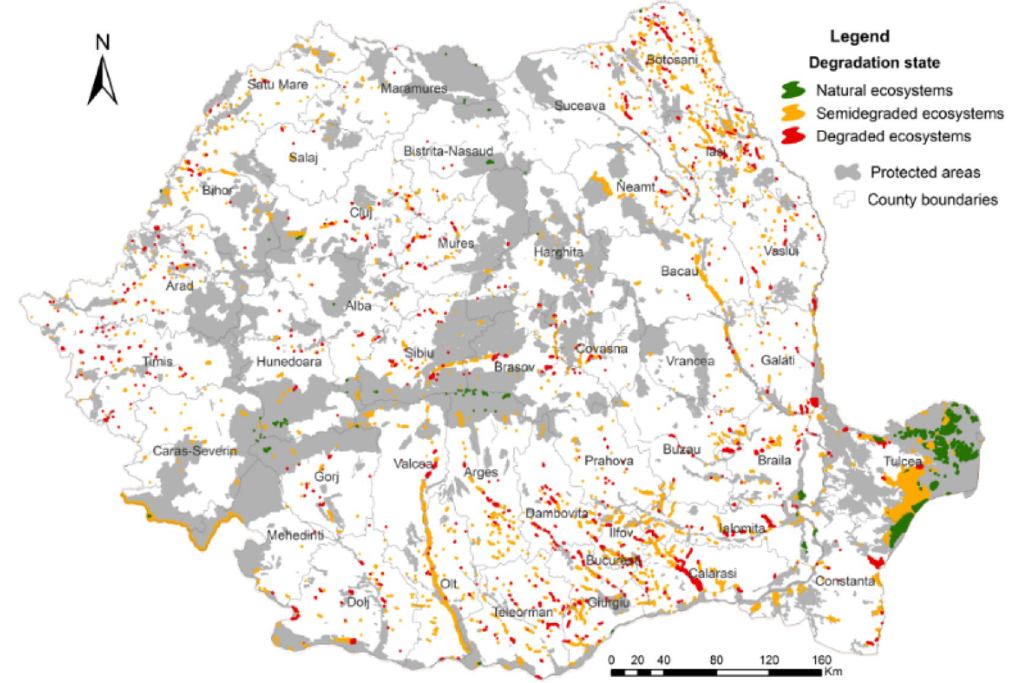
Figure 3. Distribution of lake categories according to the state of degradation and the relationship with protected areas of national and international interest in Romania (this map was created with Arc GIS 10.5 software).